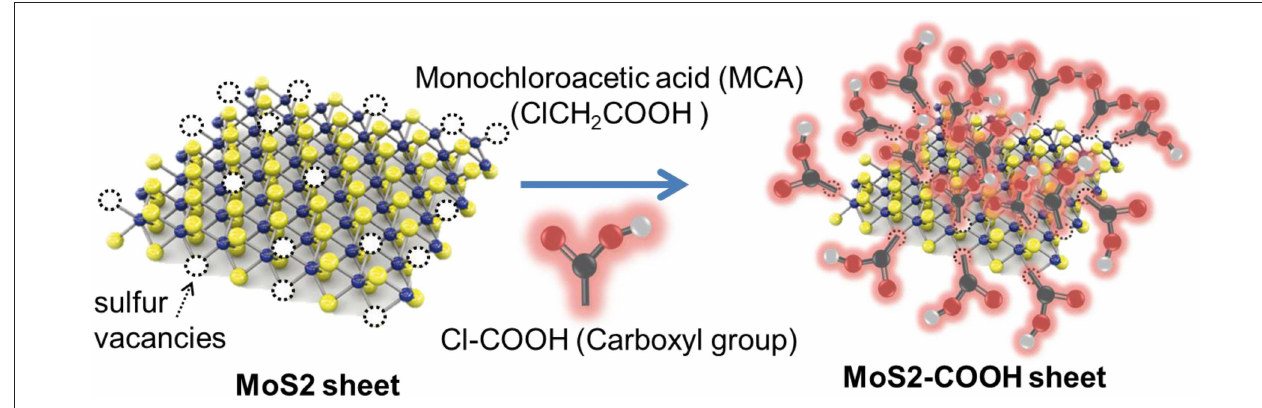
Frontiers in Chemistry |